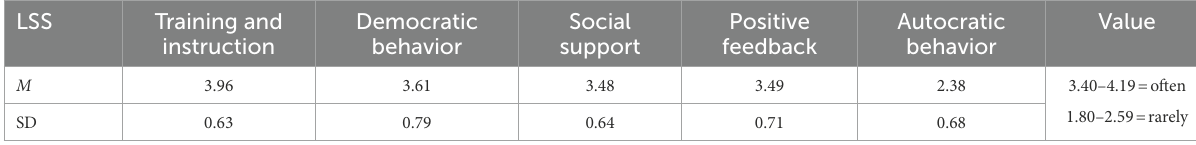
TABLE 1 Correlation Spearman’s rho, mean, standard deviation on the LSS ( n = 236).